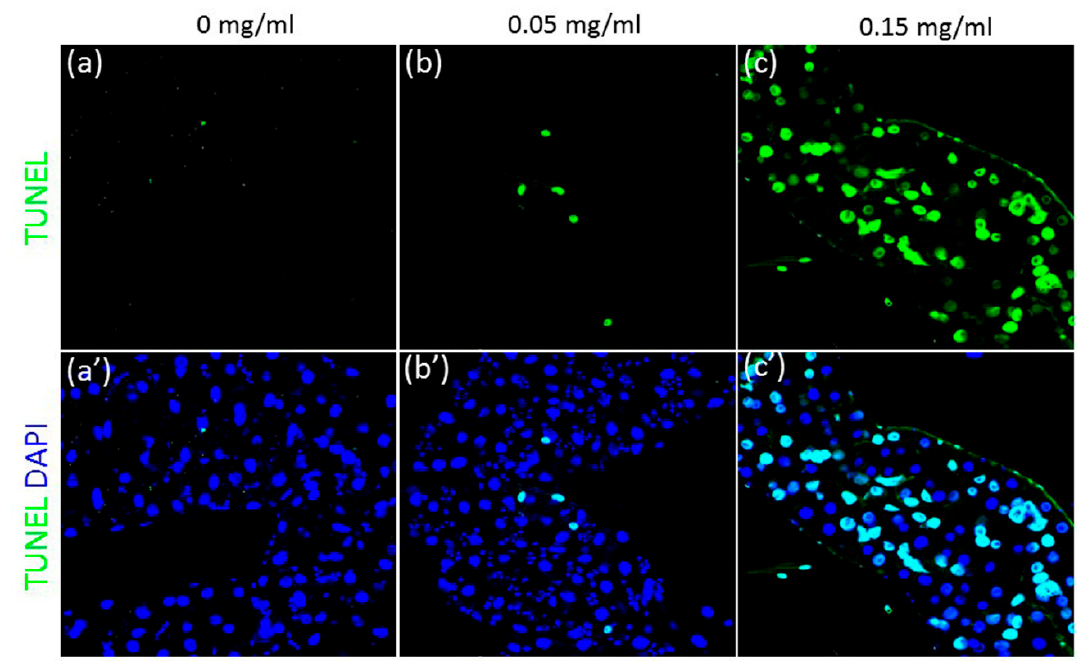
Figure 4. CuONP exposure causes apoptosis of the gut epithelia cells. Flies were exposed to CuONPs at the concentration of ( a , a’ ) 0 mg/mL, ( b , b’ ) 0.05 mg/mL and ( c , c’ ) 0.15 mg/mL. The third instar larval guts show a dose-dependent increase in the number of terminal deoxynucleotidyl transferase dUTP nick end labelling (TUNEL)-positive epithelial cells (green).